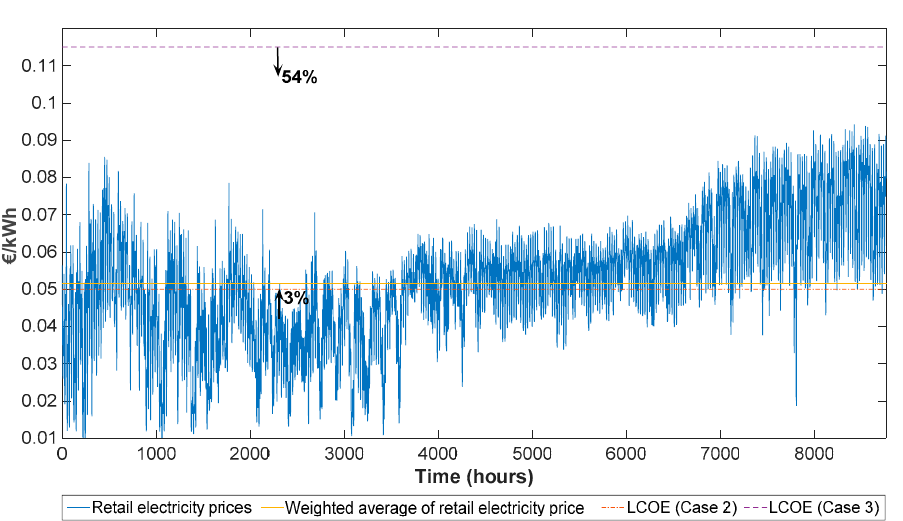
Figure 14. Annual retail electricity pricing for the commercial sector in 2016 and levelized cost of electricity ( LCOE ) in the studied application cases.